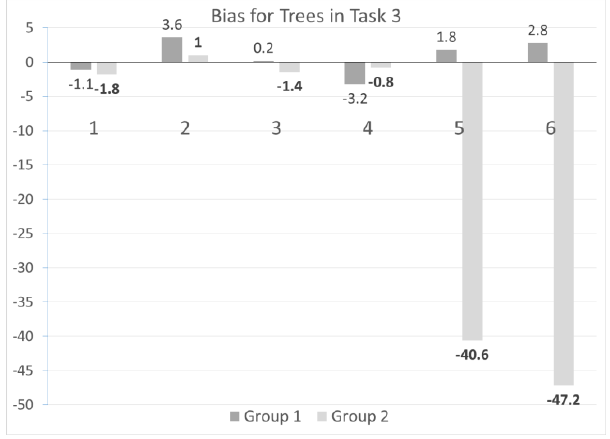
Figure 4. The bias of tree height in task 3.